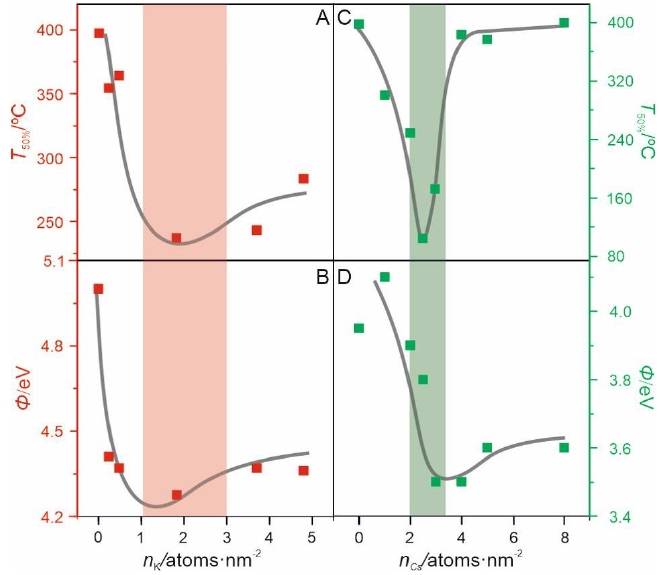
Figure 6. The half conversion temperature of N 2 O ( T 50% ) ( A , C ) and work function ( Φ ) ( B , D ) as a function of potassium ( A , B ) and cesium ( C , D ) loading introduced from a carbonate precursor.